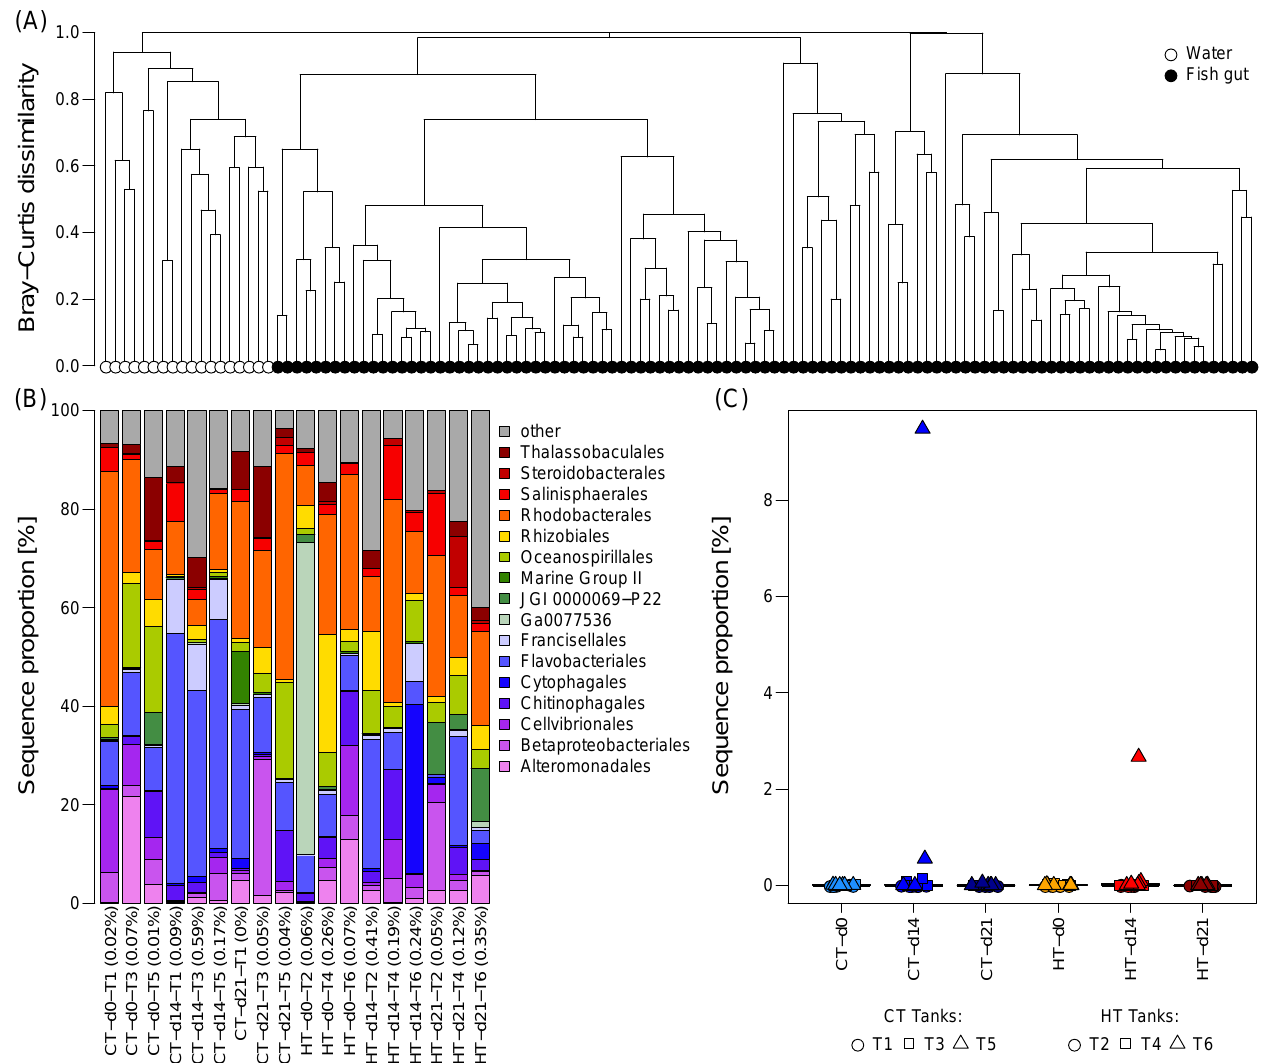
Figure 1. Comparison of microbial community composition of the tank water and the milkfish gut. ( A ) Complete linkage hierarchical cluster diagram based on Bray-Curtis dissimilarities of relative OTU proportions, ranging between 0 (most similar) to 1 (most dissimilar). ( B ) Taxonomic composition of water microbial communities at order level. Percentages in parenthesis indicate contribution of OTUs that cumulatively comprise 70% of the gut microbiome in any of the sampled fish per tank and sampling timepoint to the water community. ( C ) Contribution of the OTUs that cumulatively comprise 70% of the water community to the fish gut microbiome in each tank and at each sampling timepoint. Temperature treatments: control temperature at 26 ◦ C (CT) and high temperature at 33 ◦ C (HT). Sampling timepoints: 0, 14, and 21 days after the temperature